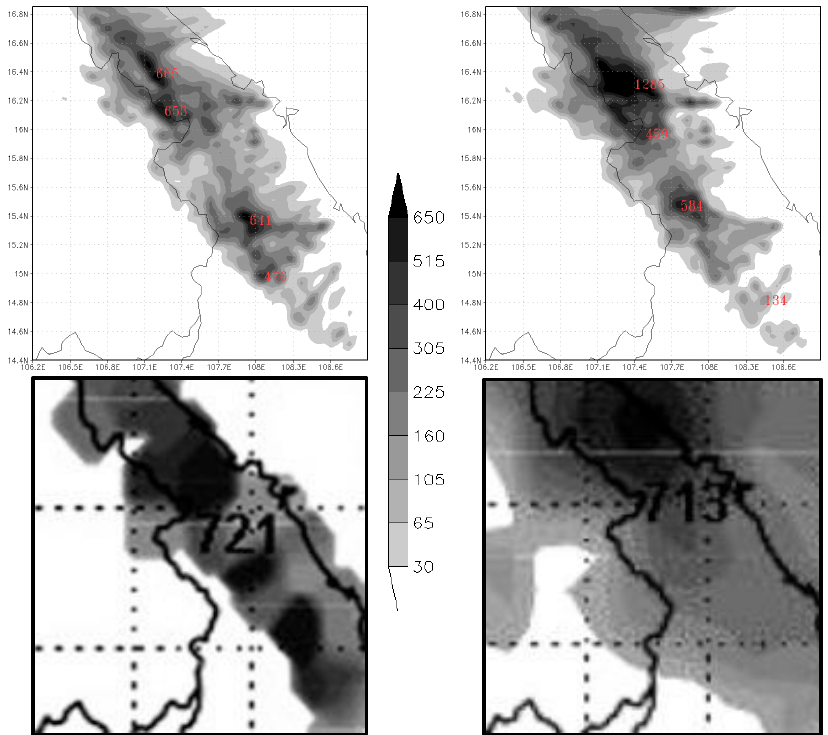
Figure 3. Accumulated precipitation 48-h precipitation (mm) for Vietnam MCS case for the area of central Vietnam. Top : WRF simulated precipitation on convective-permitting domain 3 (2.5 km grid spacing) for native KF ( left ) and modified KF ( right ). Values of local precipitation maxima indicated in red. Bottom : Equivalent objective analyses of the observed gauge-derived precipitation ( left ), and TRMM data ( right ). Number in black is the absolute maxima measured at Thuong Nhat station (16.128° N, 107.688° E).